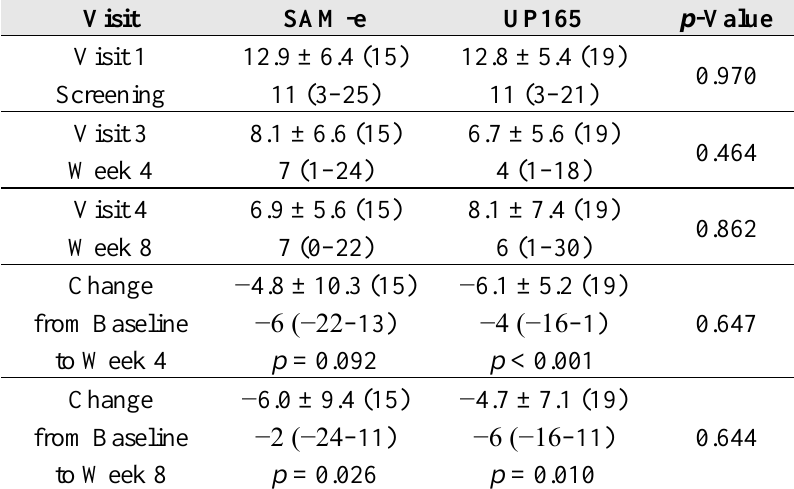
Table 3. BAI: Beck Anxiety Inventory.